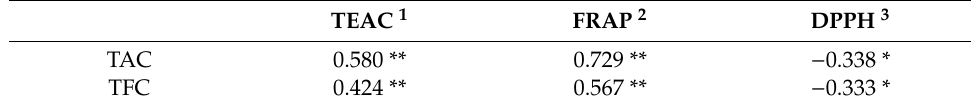
Table 4. Correlation coe ffi cients of total anthocyanin content (TAC) and total flavonoids (TFC) and each antioxidant activity